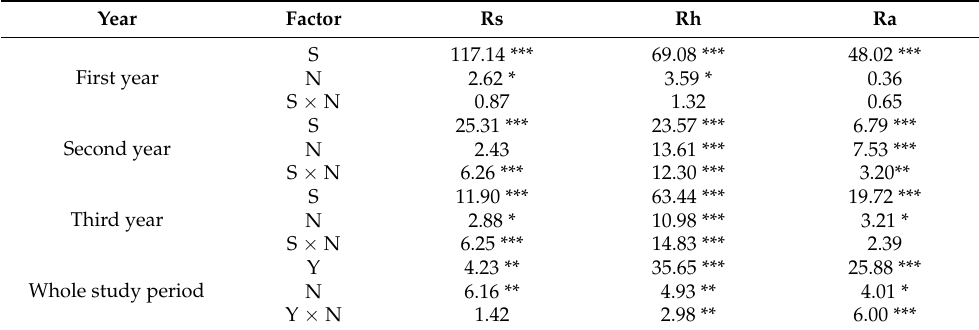
Figure 3. Annual mean values of soil respiration (Rs), autotrophic respiration (Ra), and hetero- trophic respiration (Rh) for N application at different rates. Data are presented in terms of mean ± standard deviation values. Different uppercase letters indicate significant differences across years for the same application rate, whereas different lowercase letters indicate significant differences across N application rates in the same year ( p < 0.05). CK, LN, and HN represent control, low, and high nitrogen applications, respectively. Rs, soil respiration; Ra, autotrophic respiration; Rh, heterotrophic respiration; S, season; Y, year; N, nitrogen application. * p < 0.05, ** p < 0.01, *** p <